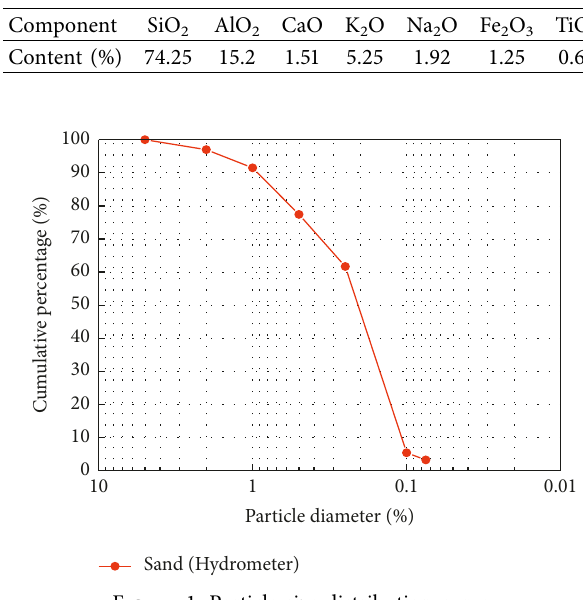
Table 3: Basic sandy soil compositions.